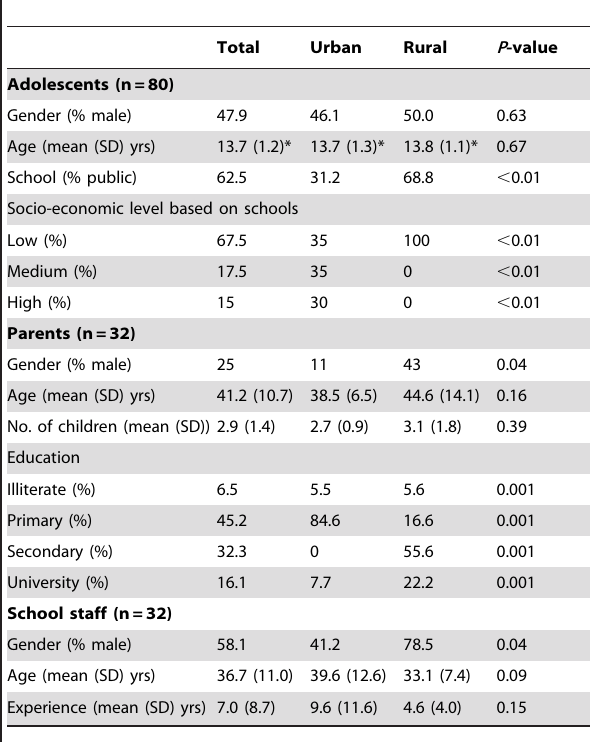
Table 1. Participant